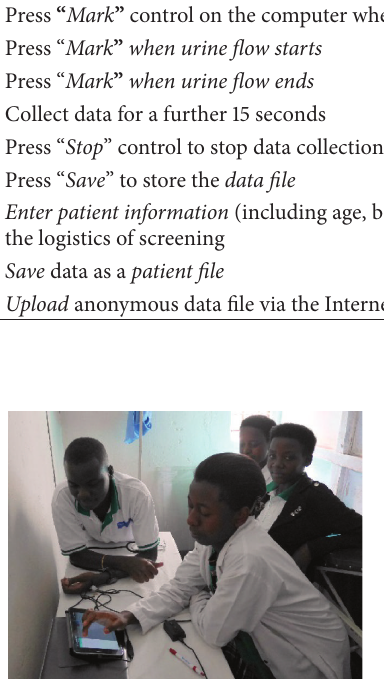
Figure 3: Small group training workshop in a rural clinic. “Hands- on” training with tablet computer interface. The tablet is connected to NIRS device via a USB charging/data transfer cable.